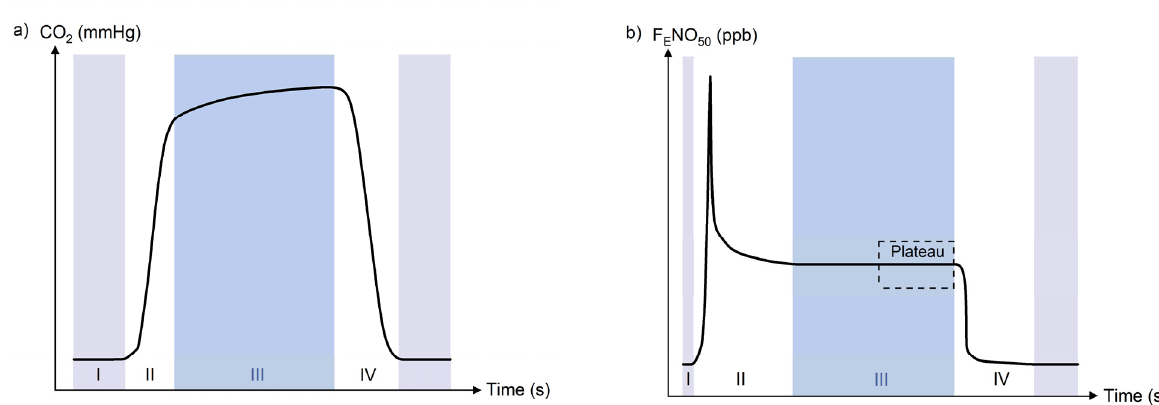
Figure 2. Schematic depictions of ( a ) the respiration cycle as described in relation to carbon dioxide (CO 2 ) partial pressure—referred to as a capnogram—comprising four transitional phases, namely: phase I, end of inspiration and dead-space gas; phase II, mixed-airway and alveolar gas; phase III, end-tidal volume; and phase IV, inspiration; note that CO 2 is offset from the vertical axis for a clearer depiction (figure adapted from [50]); and ( b ) fraction of exhaled nitric oxide (F E NO) during respiration through the mouth at a flow rate of 50 mL/s, with depicted phases representing: phase I, inspiration with air; phase II, mixed-expiratory gas, including the initial peak of exhaled NO after inhalation via the nose (from local nasal NO production); phase III, steady flow region (the 3 second plateau from which the F E NO value is extracted is indicated); and phase IV, inspiration (figure adapted from [51]).